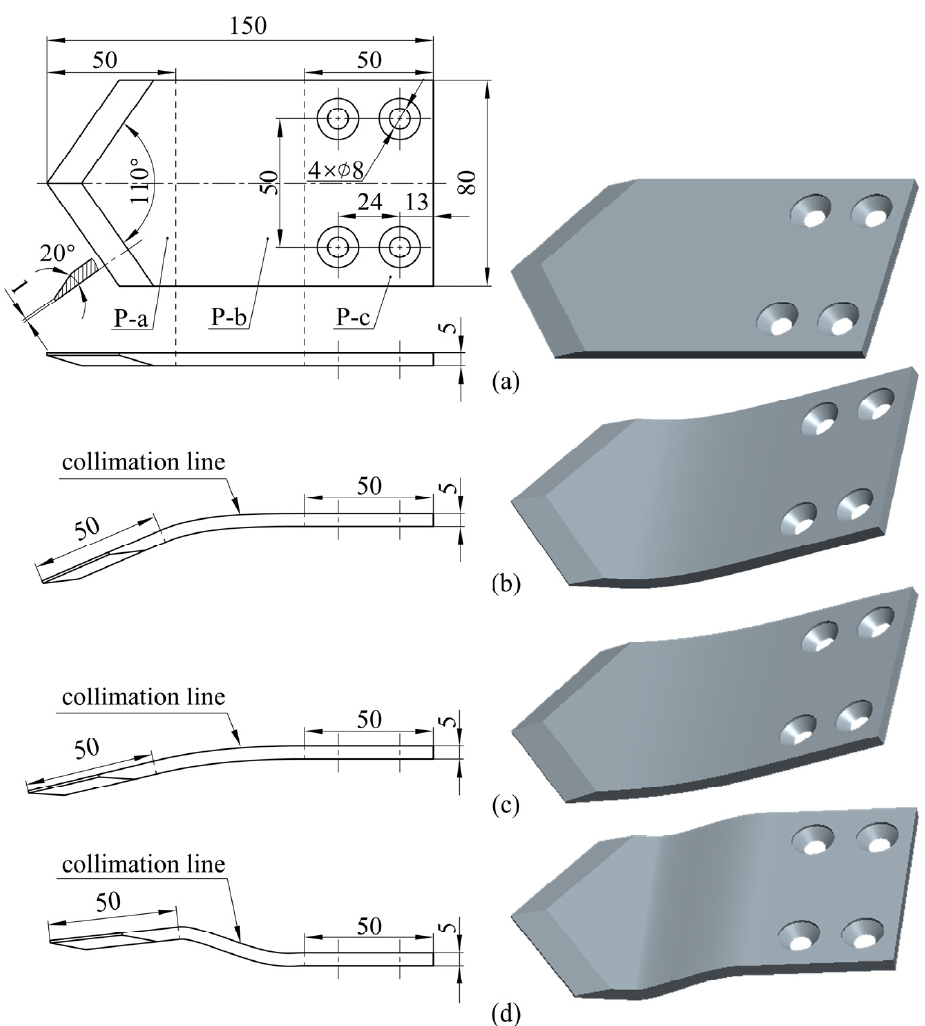
Figure 1. Detail drawings ( left , dimensions in mm) and 3D models ( right ) of PDSs. ( a ) DZ, ( b ) YS, ( c ) SS and ( d ) ZF. ( c ) SS and ( d ) ZF. Table 5. Equation of the collimation line of PDSs with a spatial surface. Table 5. Equation of the collimation line of PDSs with a spatial surface. Shovel